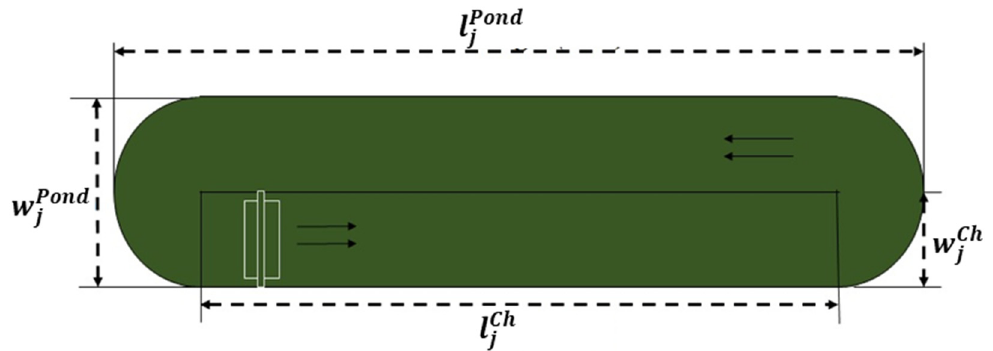
Figure 3. Schematic of a raceway pond, indicating the physical dimension used in the pond model [8].